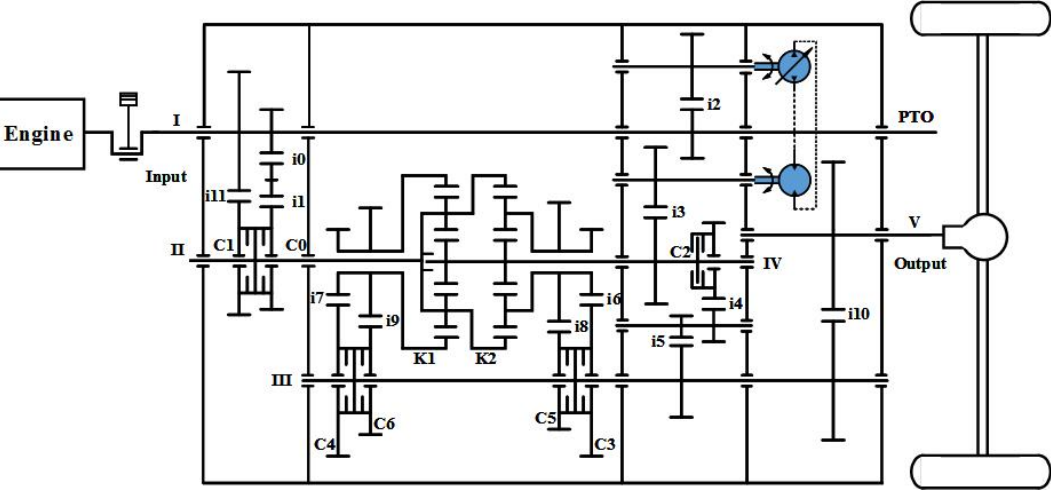
Figure 1. Transmission principles of an HMCVT (I, II, III, I, II, III, IV, V represent the different drive shafts; C1,C2, C3, C4 represent different clutches; i1, i2, …, i11 represent different gear pairs).